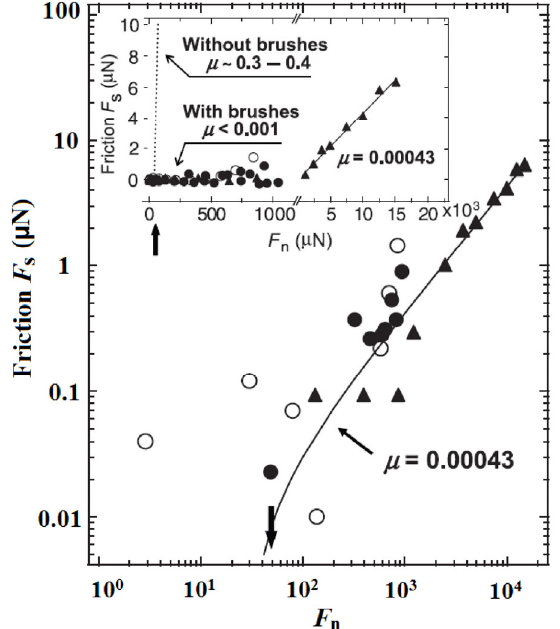
Fig. 10 Variation of friction F s with load F n and with sliding velocity, and vs. PMPC brush–coated surfaces. Reproduced with permission from Ref. [37]. Copyright American Association for the Advancement of Science,